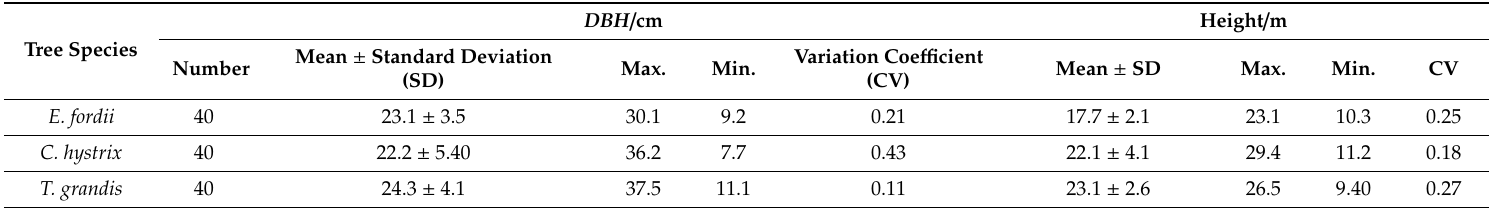
Table 1. Statistics of diameter at breast height ( DBH ) and height in the sampled plots